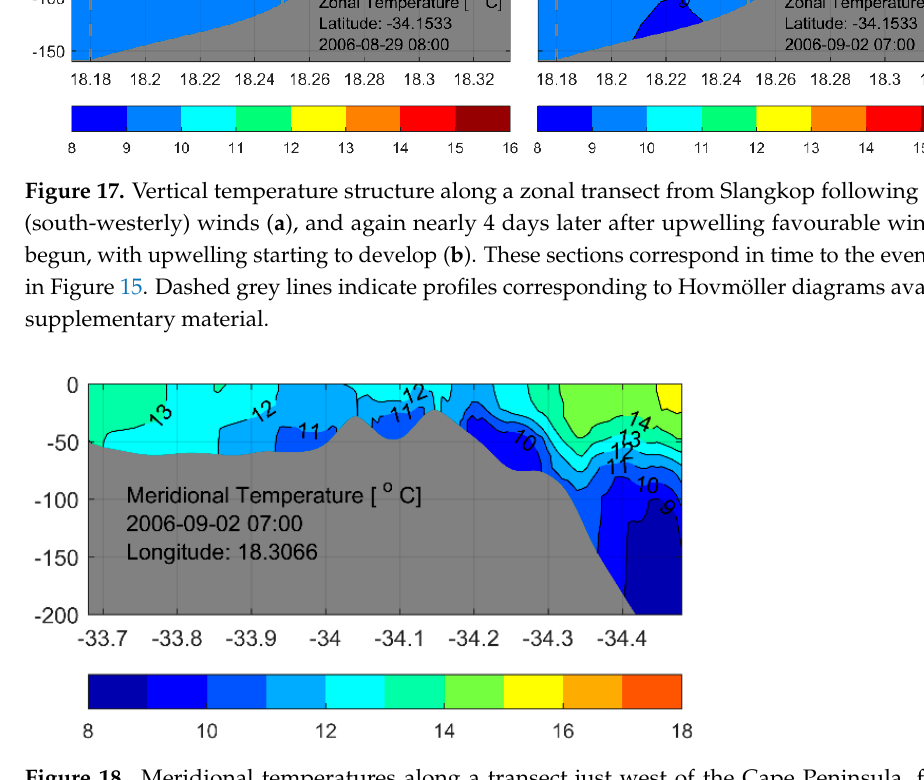
Figure 18. Meridional temperatures along a transect just west of the Cape Peninsula, from the northern to southern HRM boundary. Deep, cold waters move northwards and pool in shallower regions, partially supplying cold water for upwelling at Oudekraal and Slangkop during the same south-easterly winds events shown in Figures 15 and 17.